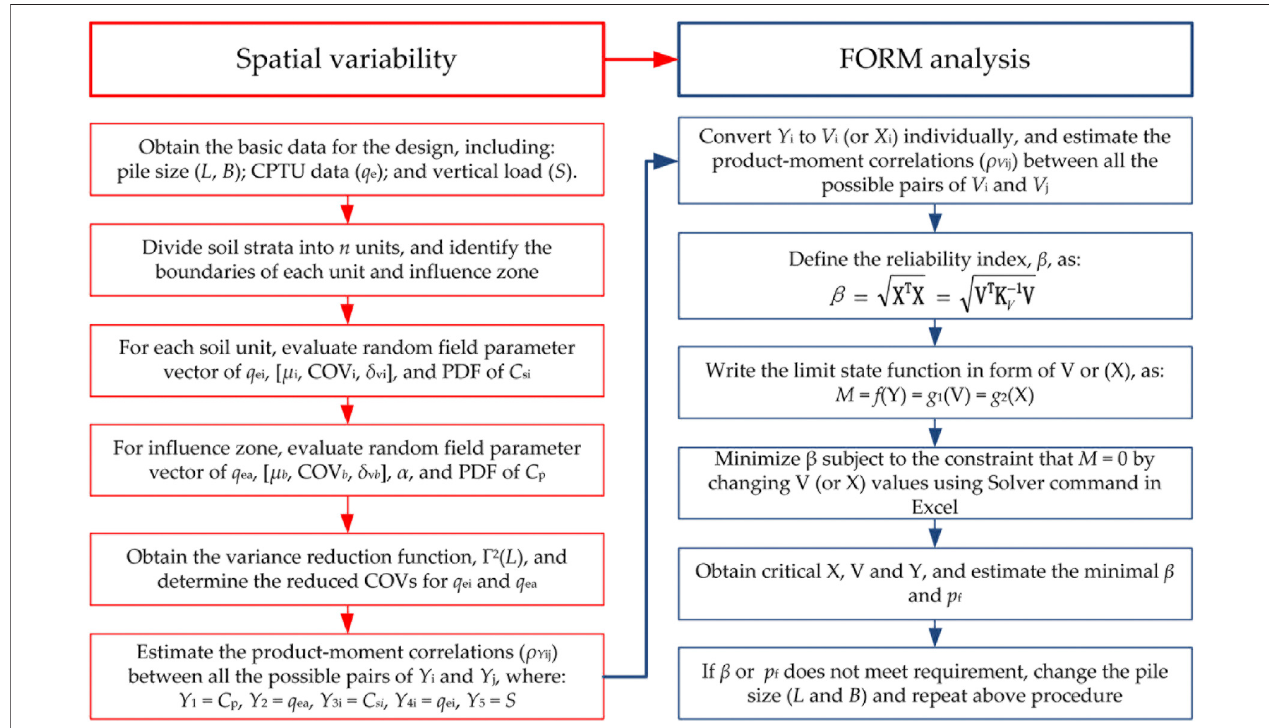
FIGURE 4 | Flowchart for the uncertainty analysis of axial pile capacity in layered soils by the UniCone method.